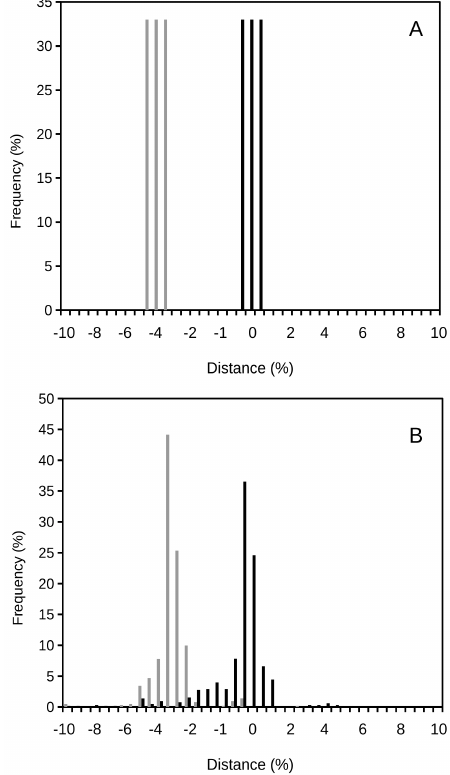
Figure 1. A visual comparison of the classical discrete species concept ( A ) and the suggested continuous species concept ( B ) for prokaryotes when plotting distance among strains versus their frequency distribution. In the classical, discrete concept, no strains or cells are considered at the distances existing in between species. Note that the continuous concept considers the existence of (either known or to be discovered) diversity and heterogeneity among the prokaryotes. Furthermore, one should consider the bell-shaped distribution, which will allow accurate statistical analyses to be applied to the taxonomic evaluation of prokaryotic species. The continuous concept also depends on the clustering of strains or variants around a reference strain, but simultaneously recognizes a continuum of features which includes the existence, or potential existence, of other prokaryotes o ff the species boundaries. In ( B ), the examples of Shigella flexneri (black) and its comparison with Escherichia coli (grey) are shown. Distance represents the percentage of dissimilarity against the reference genome.